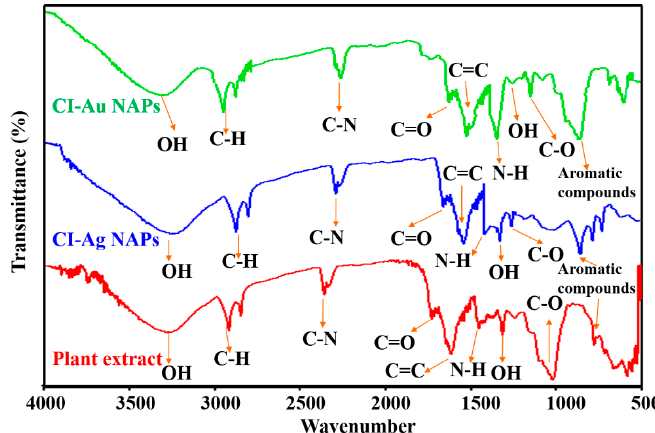
Figure 4. Absorption spectra of ( a ) extract of C. inerme leaves, ( b ) CI-Au NPs and ( c ) CI-Ag NPs.